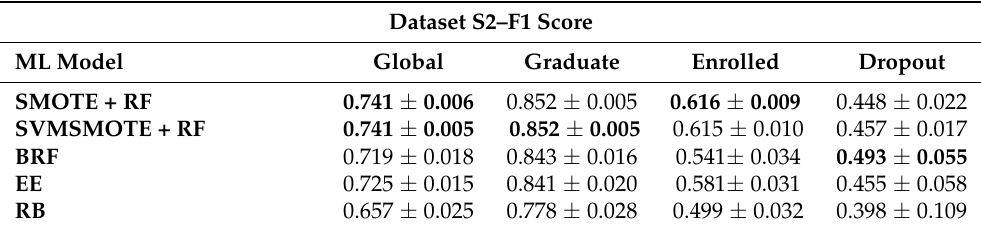
Table 8. F1 score evaluation for each class for each learning model built with information at the end of second semester. Values represent mean and standard